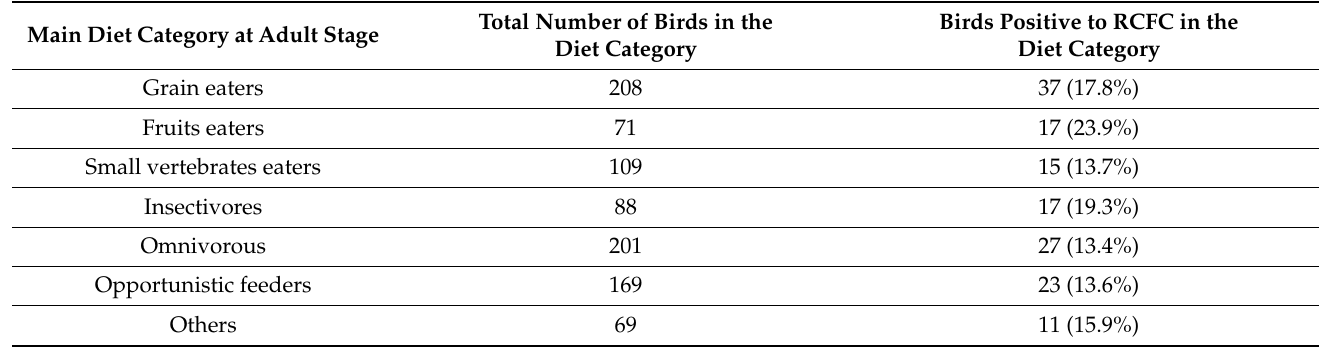
Table 4. Distribution of birds according their main diet at adult stage. Grain eaters indicates birds feeding mainly on grain and/or seeds at adult stage; Fruit eaters indicates birds feeding mainly on fruit and/or berries at adult stage; Small vertebrate eaters indicates birds feeding on a variety of small terrestrial vertebrate preys such as mice, voles, small reptiles and small birds at adult stage; Insectivore indicates birds feeding on a wide variety of insects and other terrestrial arthropods such as spiders at adult stage; Omnivorous feeders indicates birds with no preferential diet between plants/grain and animals; Opportunistic feeders indicates birds with a wide variety of food sources that also scavenge on human wastes; Other group indicates birds with a diet that does not fit into any of the previous groups. This includes specialist feeders, birds feeding on invertebrates other than insects such as annelids, molluscs or crustaceans, birds feeding on aquatic food sources such as fishes or amphibians. Birds with several main diets (for example grain eater and fruit eaters) were counted once in each